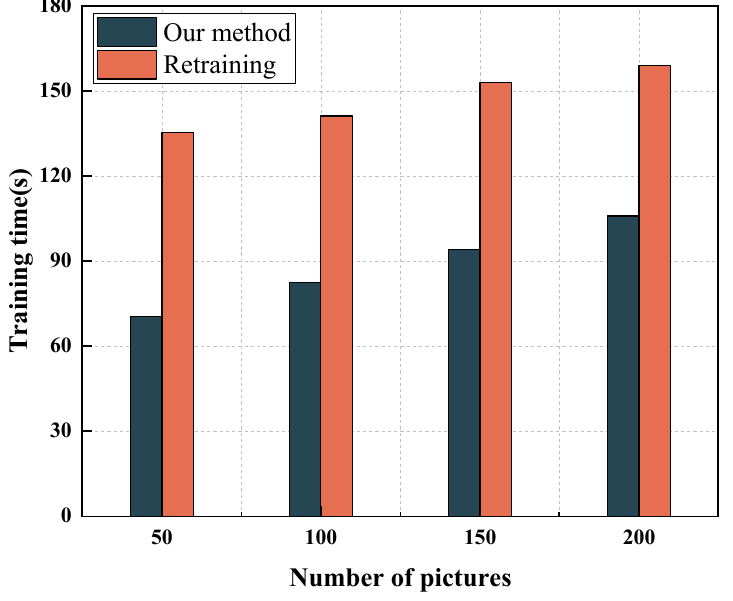
Figure 9. Training time for both methods.